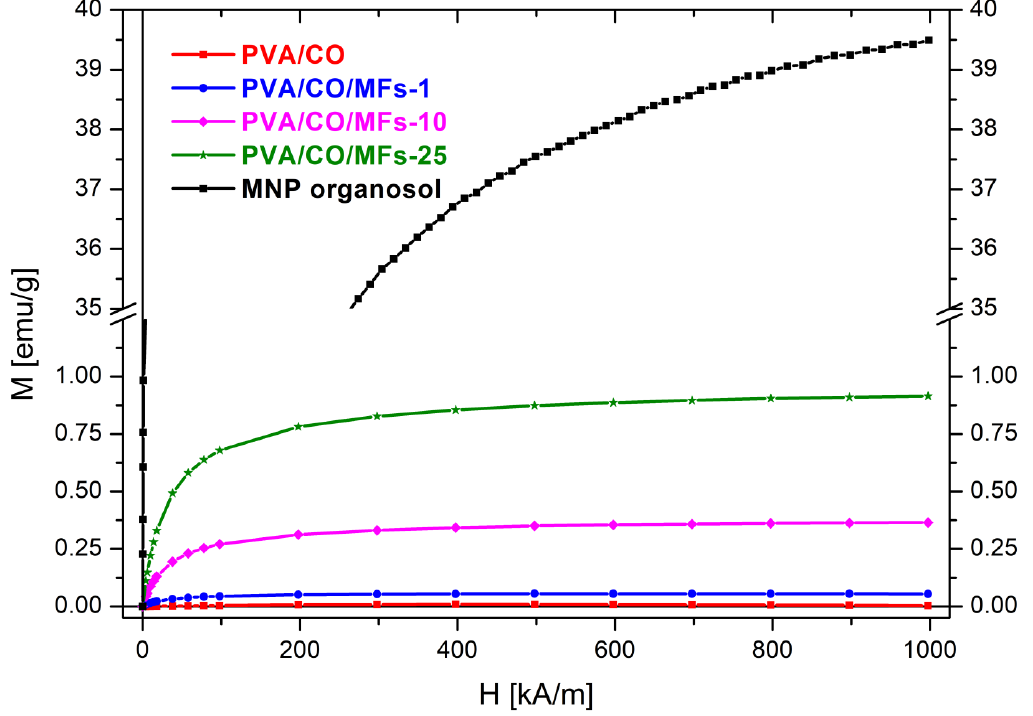
Figure 5. Magnetization curves of the hydrogels and MNP organsol.